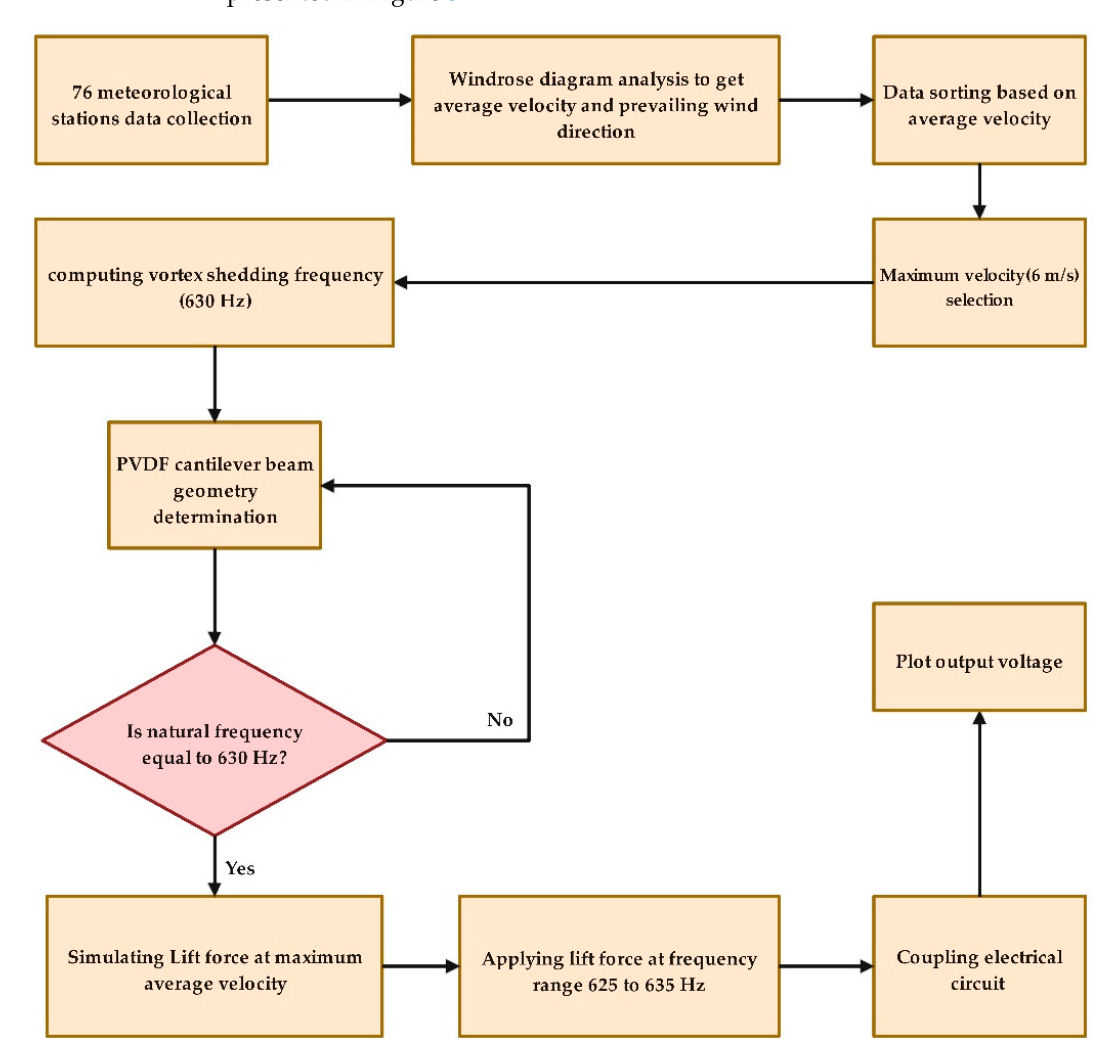
Figure 3. Energy harvesting simulation flowchart.